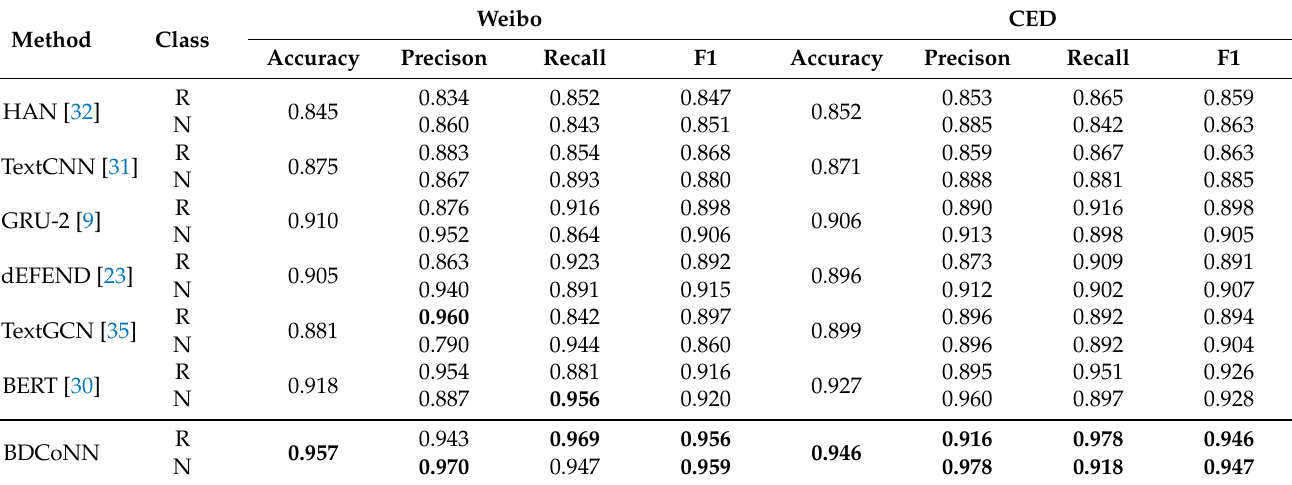
Table 3. Comparison of experimental results